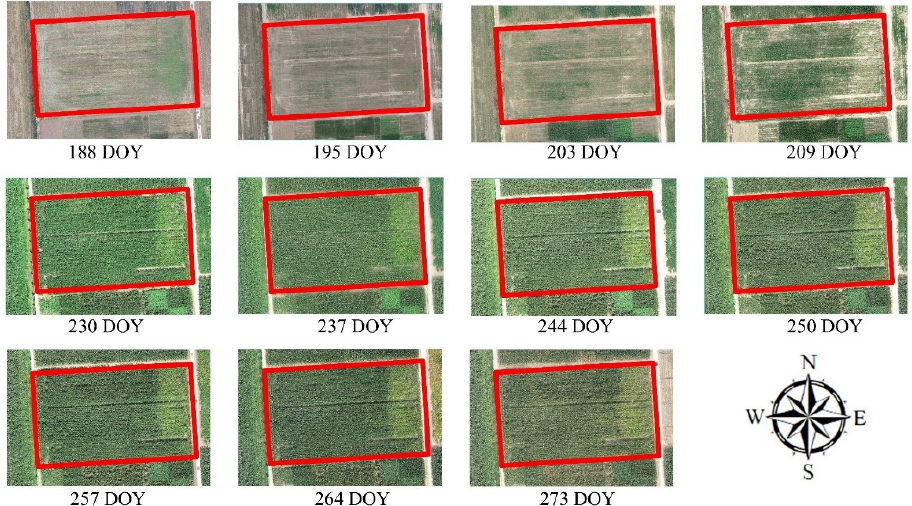
Figure A1. The RGB images at different growth stages of maize.